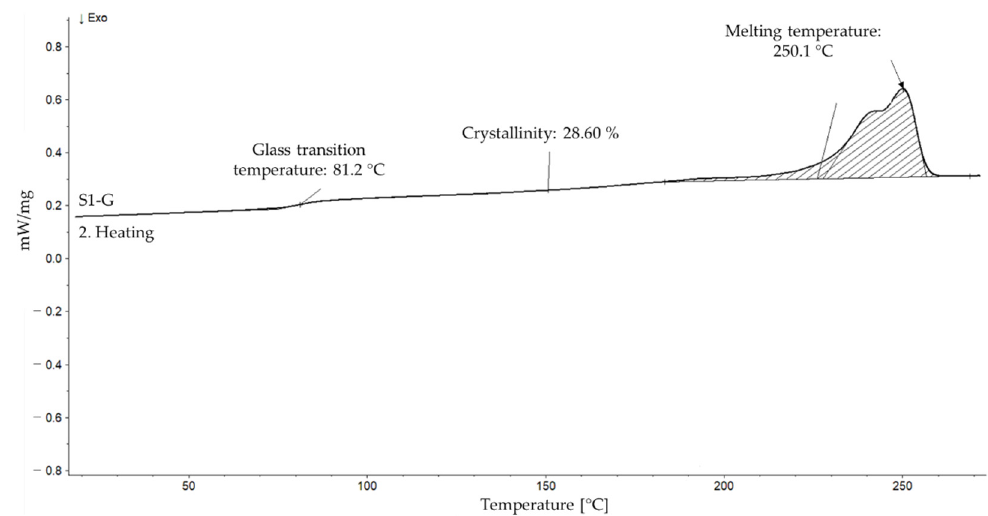
Figure 3. Exemplary evaluation of a DSC curve on the example of the S1-G sample.